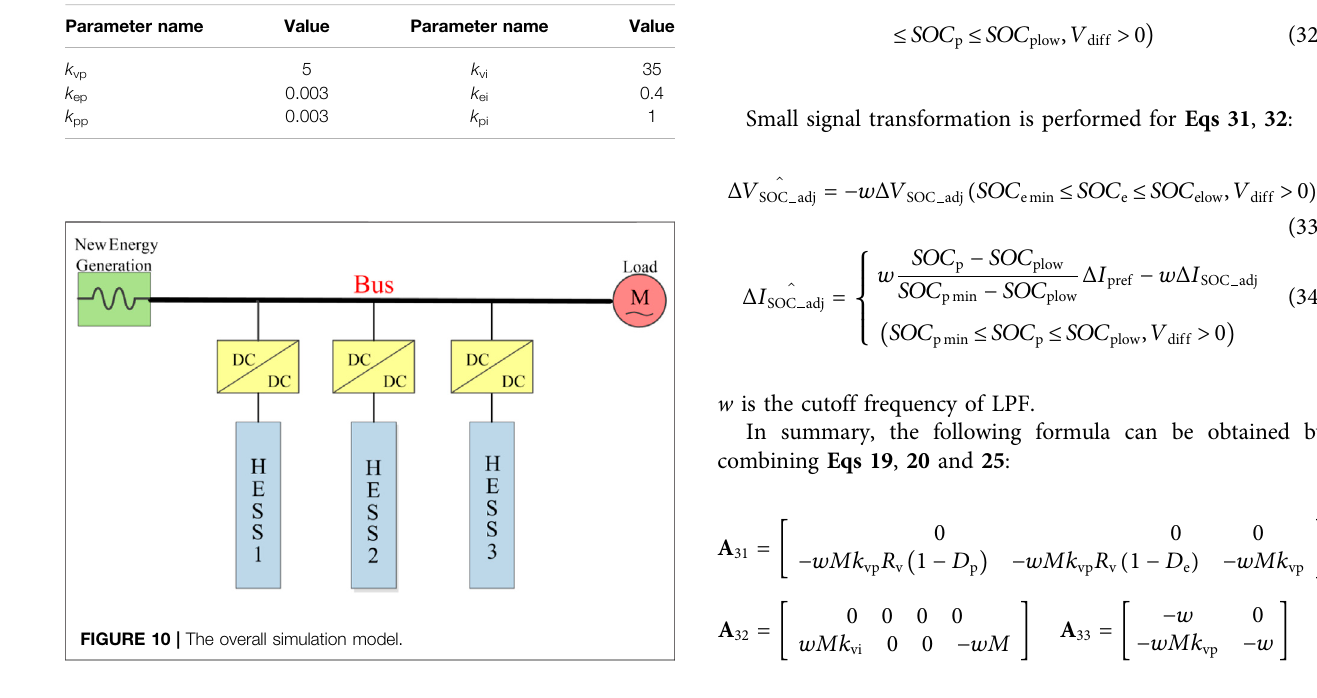
TABLE 2 | PI parameter.